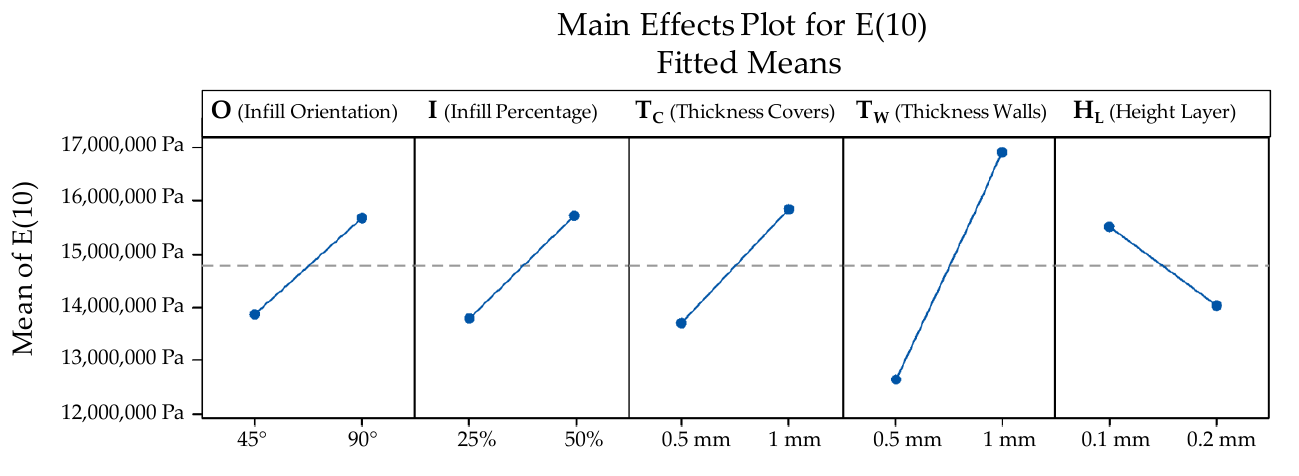
Figure 8. Main effects plot for 𝐸(10) .